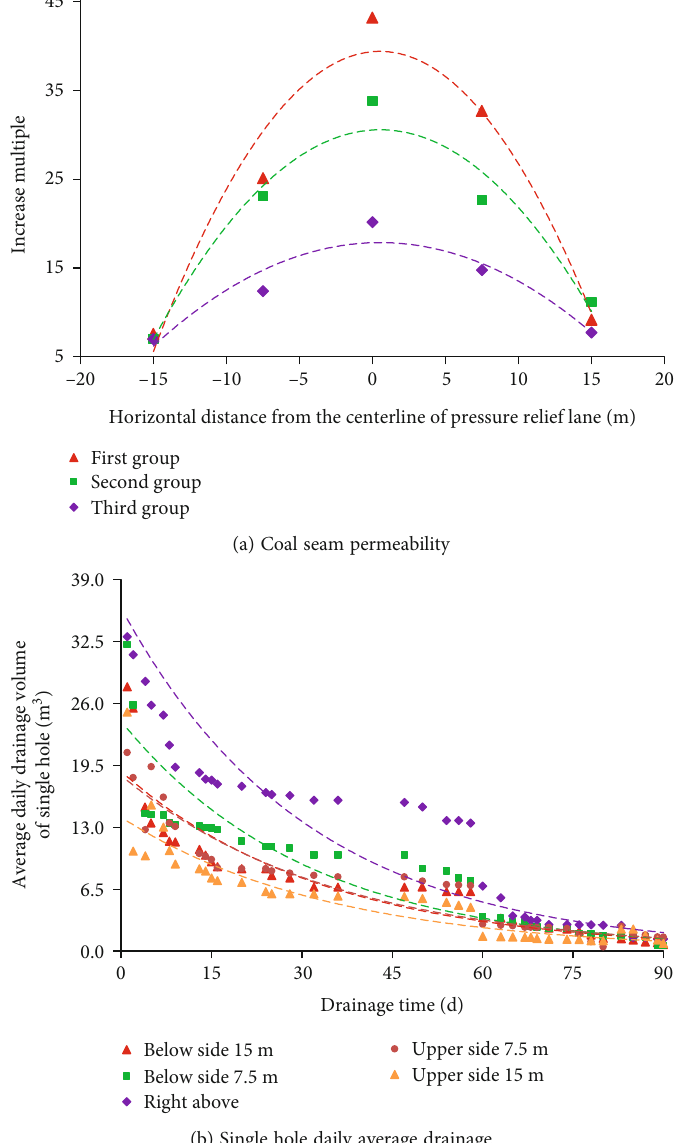
Figure 10: The permeability enhancement e ff ect of the overlying coal seam above 213 pressure relief